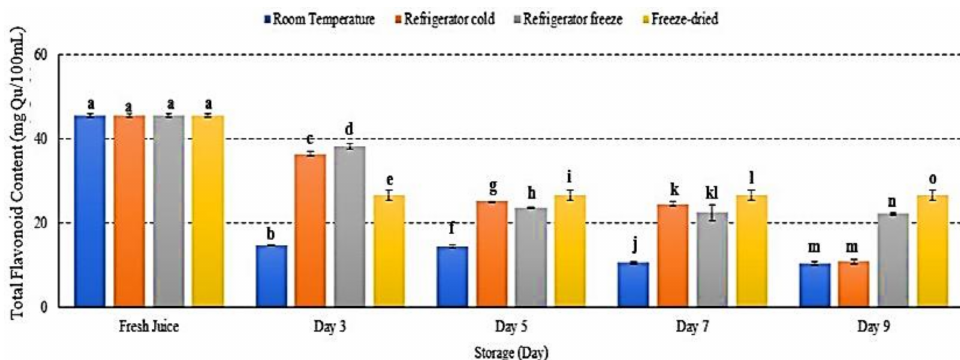
Figure 9. The TFC in watermelon juice during storage. Different letters indicate significant differences between samples p < 0.05.